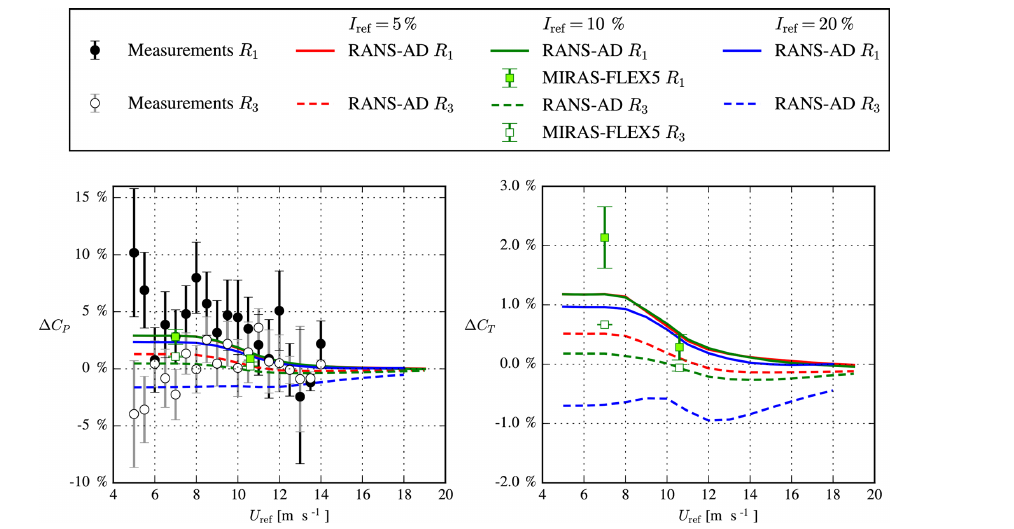
Figure 11. The rotor individual relative difference between the 4R-V29 wind turbine with all rotors in operation and the 4R-V29 wind turbine with a single rotor in operation, in terms of power and thrust as function of the free-stream velocity at a height of 44.27m.